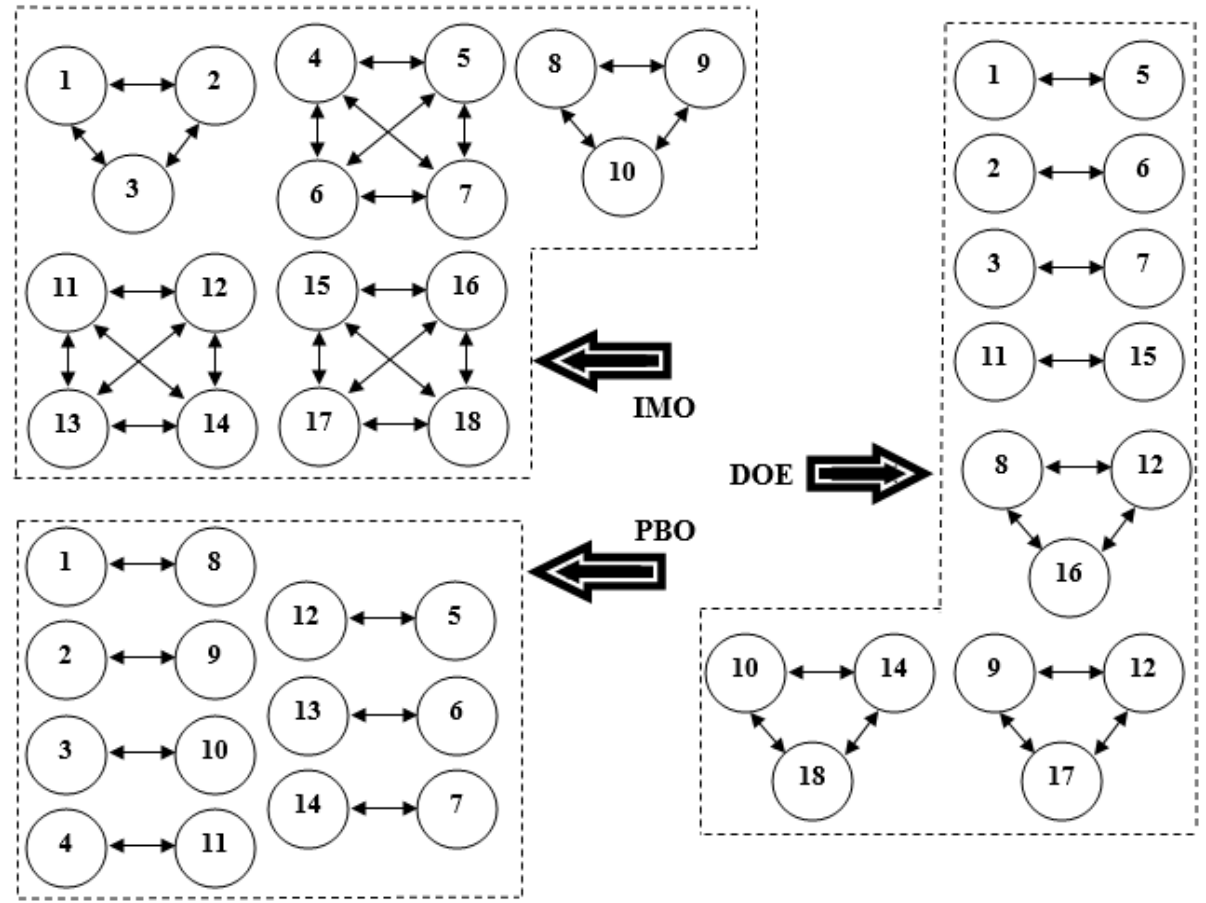
Figure 4. One-way progress graphs for Markazi province industrial land development conflict among stakeholders.